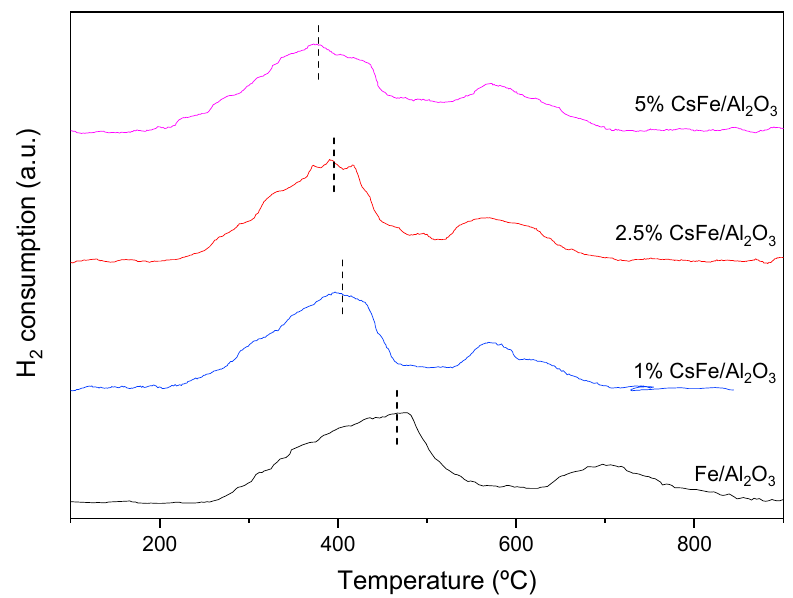
Figure 3. TPR profiles of the calcined samples.